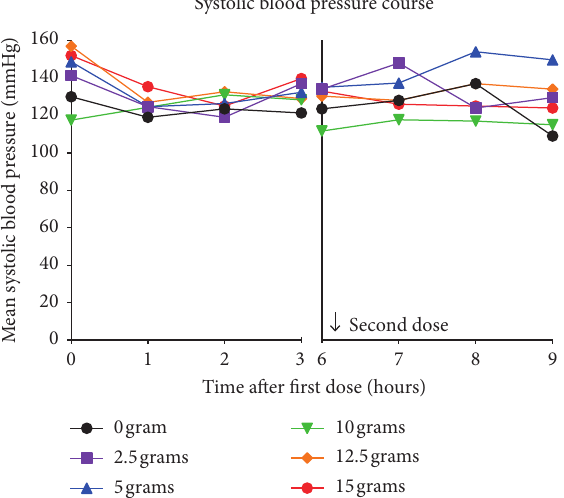
Figure 1: Systolic blood pressure